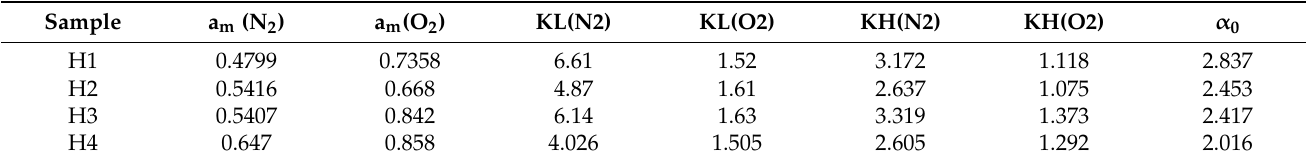
Table 5. Adsorption capacity (a m , mmol/g), Langmuir constants (K L , 10 3 mm Hg − 1 ), Henry constants